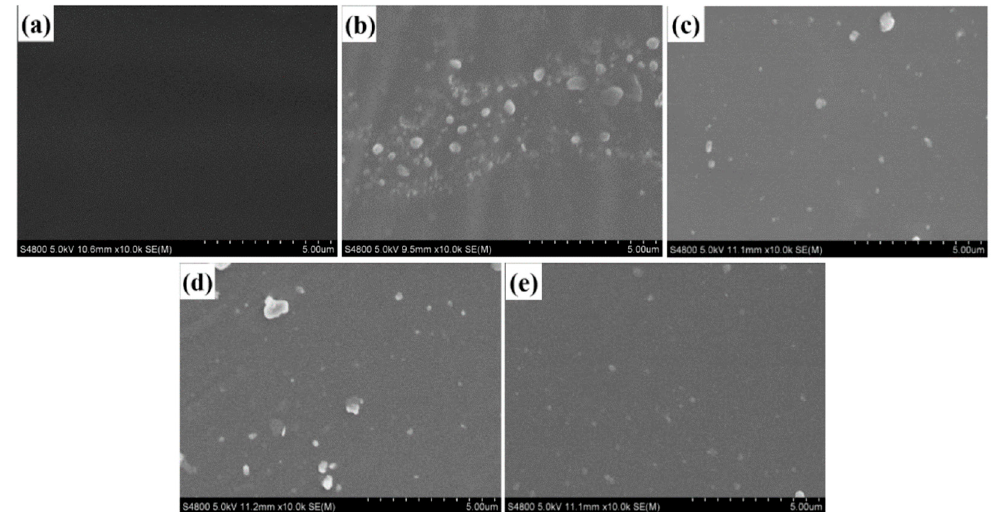
Figure 10. SEM of composite films: ( a ) PMA, ( b ) PMA/SiO 2 , ( c ) PMA/KH550-SiO 2 , ( d ) PMA/KH560-SiO 2 and ( e ) PMA/KH570-SiO 2 ).